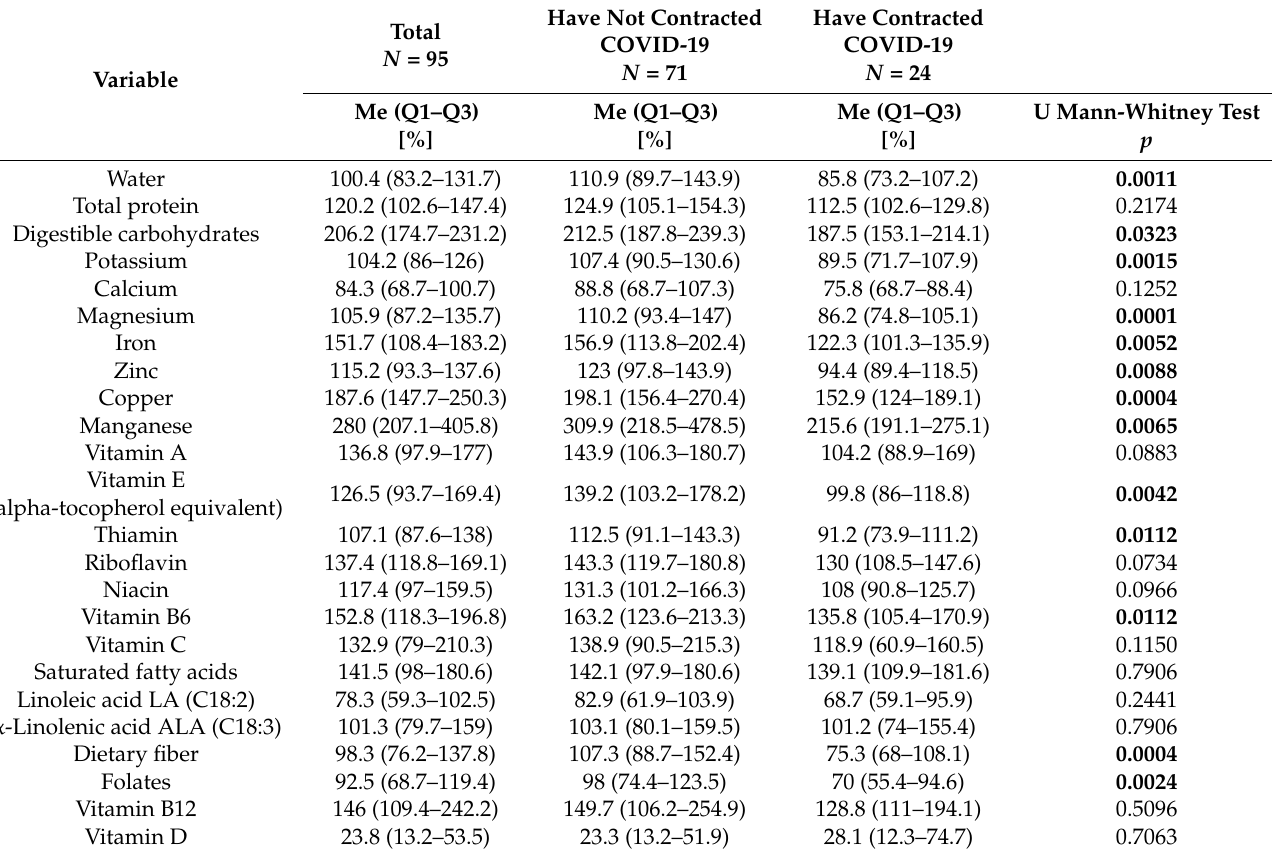
Table 3. Percentage of reference intake for individual macronutrients, vitamins, and minerals in the whole study group and according to the history of